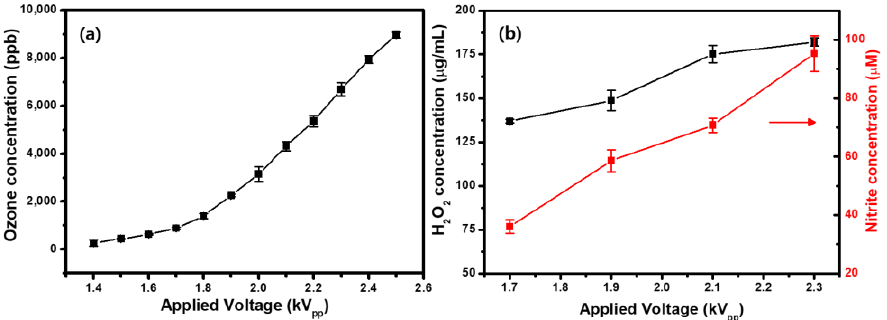
Figure 3. ( a ) Ozone (O 3 ) concentration as a function of the applied voltage. ( b ) Generation of hydro- gen peroxide (H 2 O 2 ) and nitrite (NO 2 − ) in cold atmospheric plasma (CAP)-treated Hanks ’ balanced salt solution (HBSS) without cells. Each point represents the mean ± SD of three replicates.